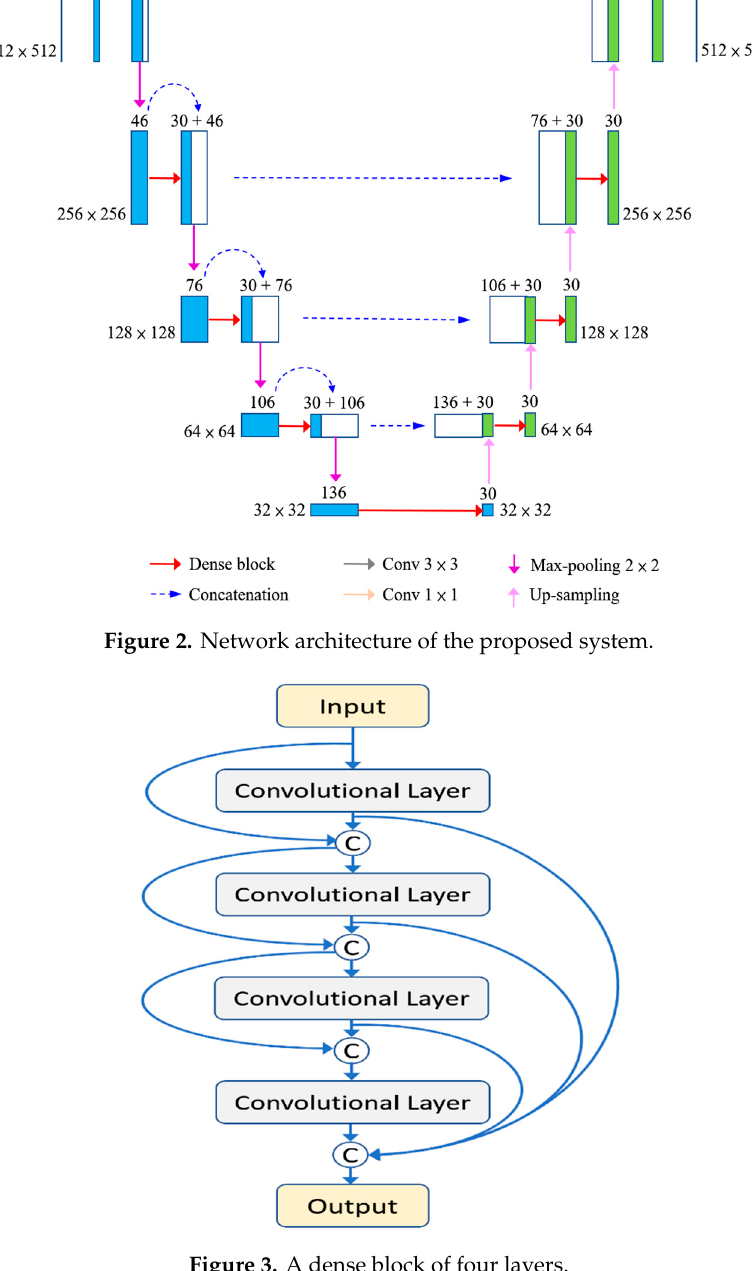
Figure 3. A dense block of four layers.